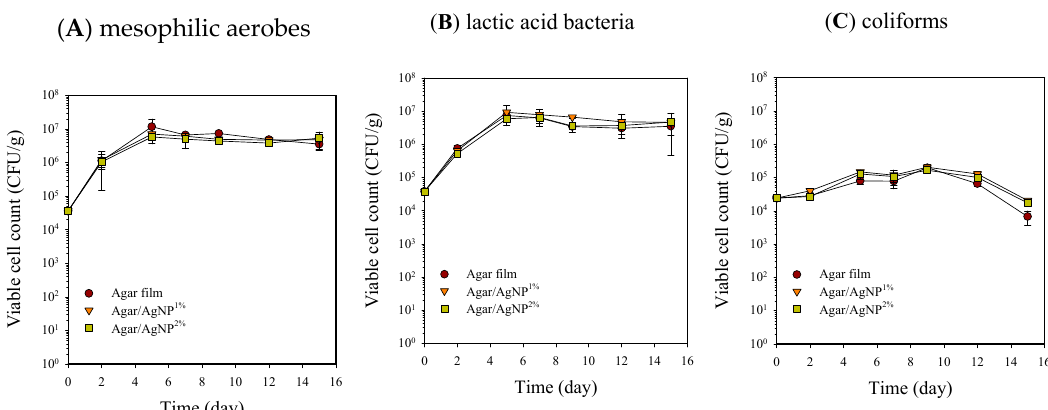
Figure 1. Changes in viable cell counts of mesophilic aerobes ( A ), lactic acid bacteria ( B ), and coliforms ( C ) in beef samples packaged with agar/AgNP composite films. Mesophilic aerobes: LSD time = 0.12 Log (CFU/g), LSD treatment = 0.08 Log (CFU/g). Lactic acid bacteria: LSD time = 0.15 Log (CFU/g), LSD treatment = 0.10 Log (CFU/g). Coliforms: LSD time = 0.09 Log (CFU/g), LSD treatment = 0.06 Log (CFU/g). ( B ) E. coli O157:H7